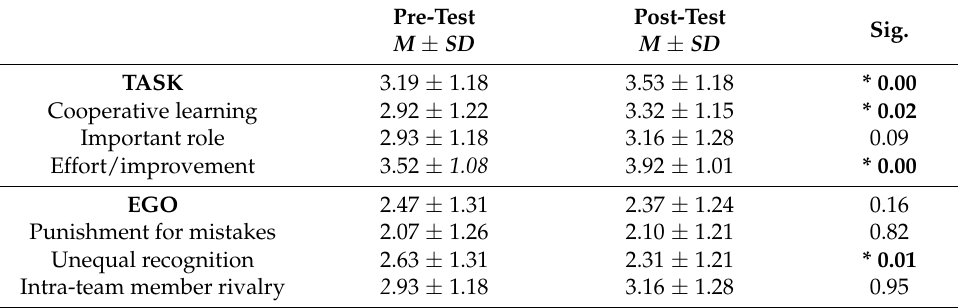
Table 4. The results of the PMCSQ questionnaire in Test group